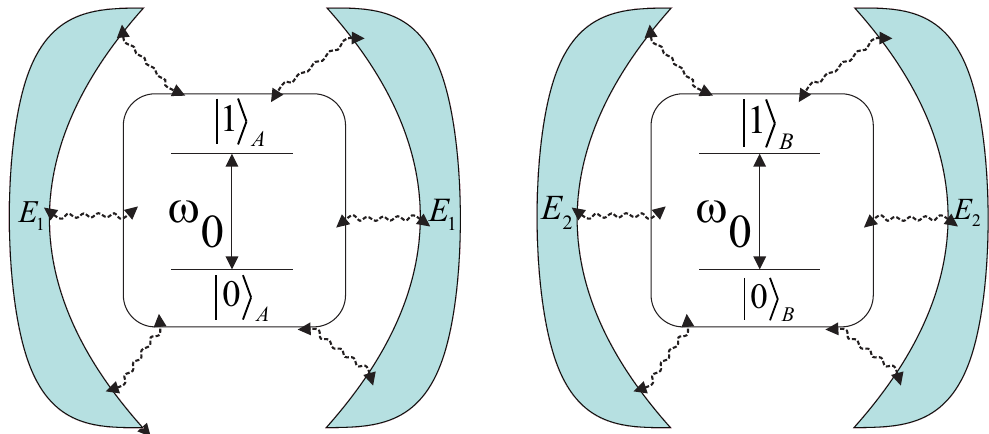
Figure 1. Schematic representation of two-level atoms A and B , which interact independently with their surrounding environments E 1 and E 2 respectively. There is no interaction between the two interacting subsystems A − E 1 and B − E 2